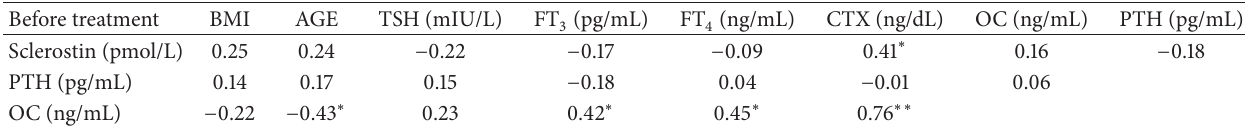
Table 3: Spearman rank correlation coefficients before therapy. Analysis of association: significant correlations are marked with asterisks: ∗ 𝑝 < 0.05 , ∗∗ 𝑝 < 0.01 . OC, osteocalcin; CTX, collagen type I cross-linked C-telopeptide. Before treatment